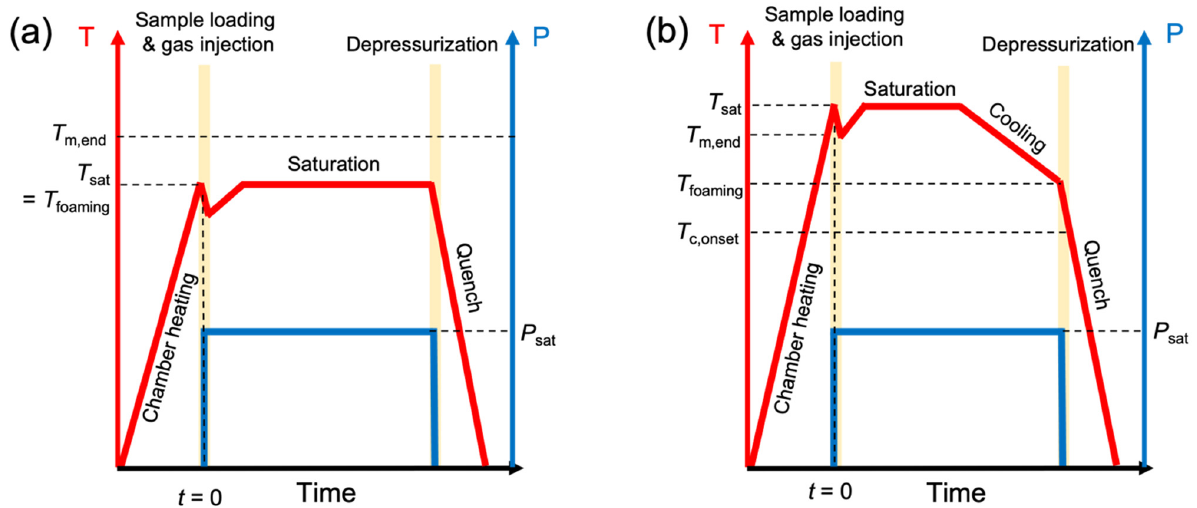
Figure 3. Temperature–pressure profile of foaming method used to investigate the effect of ( a ) partial (Method 1) and ( b ) complete melting (Method 2) on PP foamability. T m,end , T sat , and T c,onset denote end melting, gas saturation, and onset crystallization temperatures, respectively.